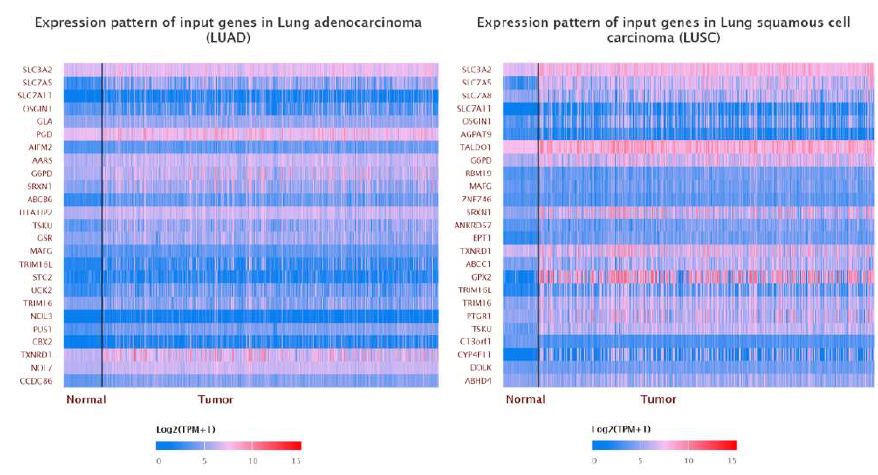
Figure 9. Correlation of SLC3A2 with other genes in LUAD and LUSC tissues.